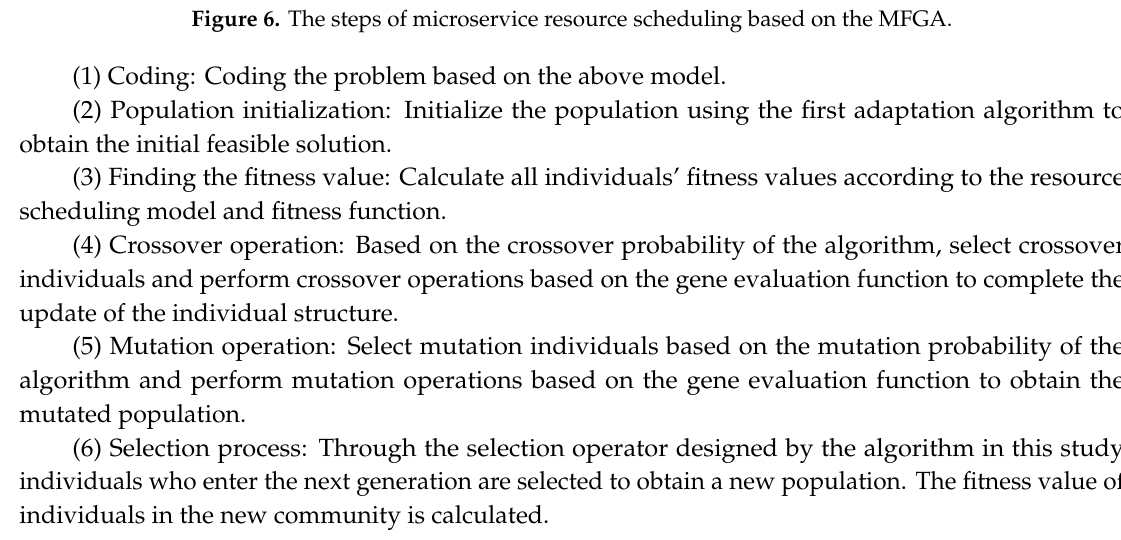
Figure 7. The flow of Container-CloudSim simulation.